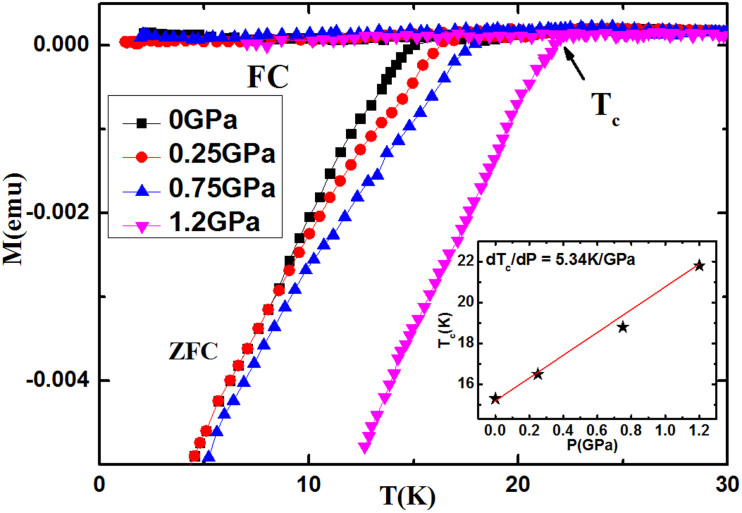
Temperature dependence of ZFC and FC moments at different pressures for Sr4V2O6Fe2As2.The inset shows the pressure dependence of Tc.